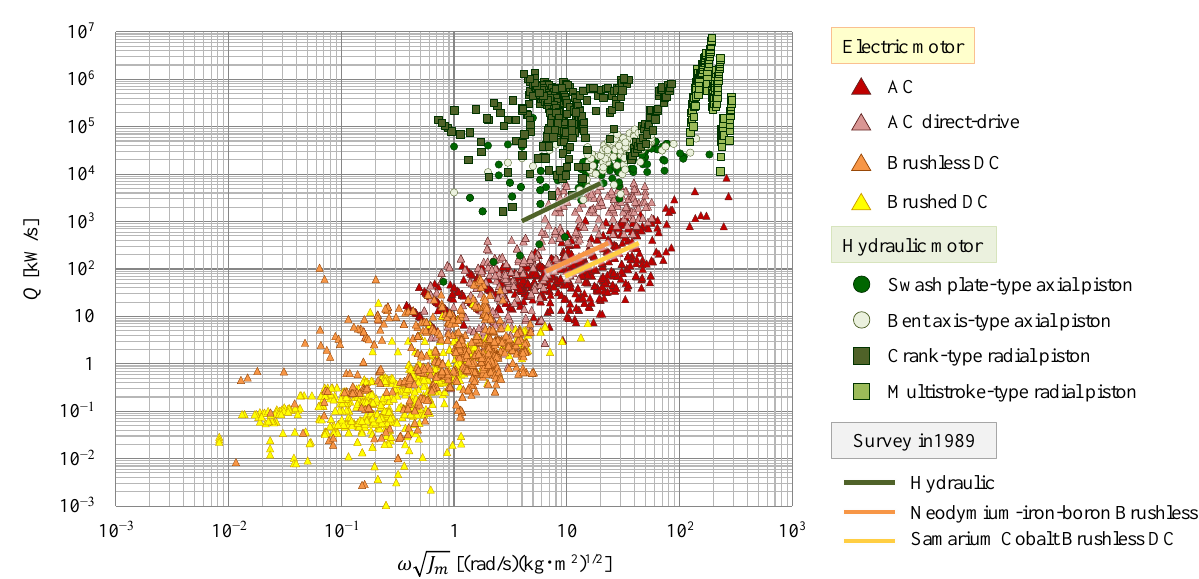
Figure 14. Correlation between output energy and power rate.